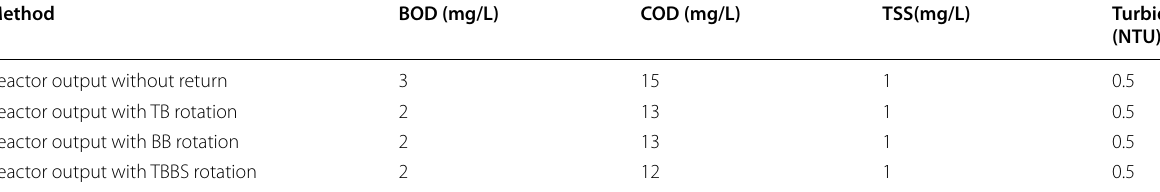
Table 6 Properties of effluent backwashing return to the reactor